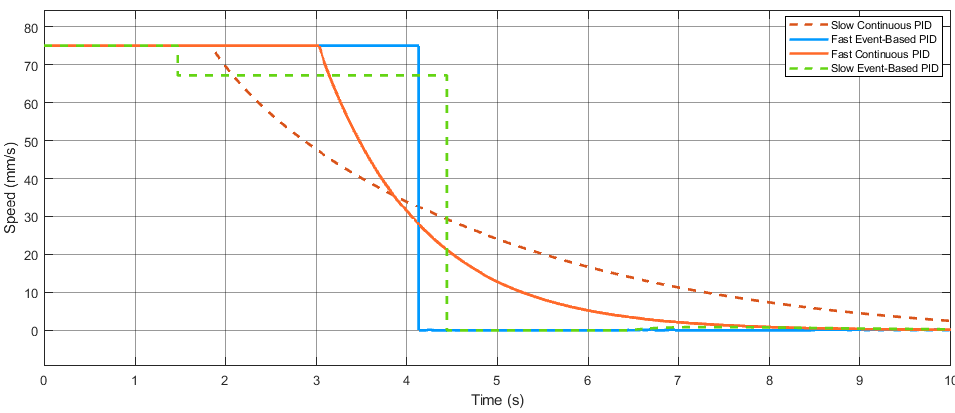
Figure 6. Event-based and continuous PID speed output in two different speed conditions.